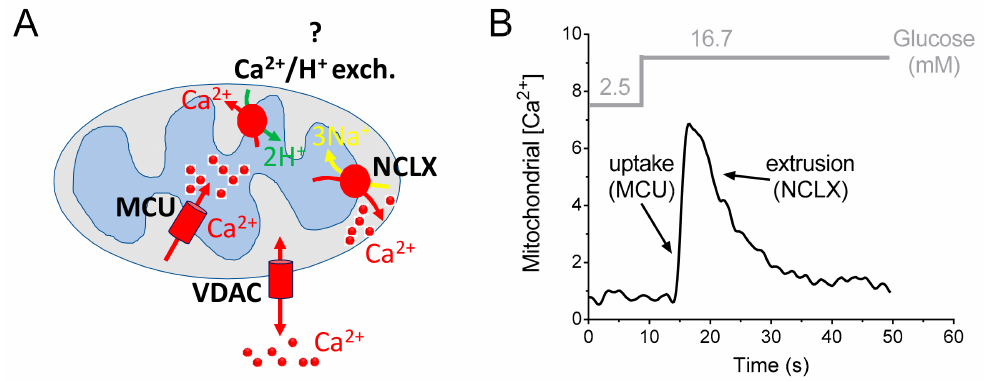
Figure 3. Contribution of mitochondrial Ca 2+ uptake and mitochondrial Ca 2+ extrusion to mito- chondrial Ca 2+ signaling in the pancreatic β -cell. ( A ) Ca 2+ transport proteins of pancreatic β -cell mitochondria. In the outer mitochondrial membrane, the voltage-dependent anion channel VDAC facilitates the diffusion of Ca 2+ , ions and other small solutes. However, mitochondrial Ca 2+ uptake is mainly regulated at the level of the inner membrane. Therefore, in β -cell mitochondria, the influx of Ca 2+ into the matrix is mediated by the Ca 2+ -selective channel MCU complex; Ca 2+ is then extruded by the Na + /Ca 2+ exchanger NCLX. The existence and the molecular identity of a pancreatic β -cell mitochondrial Ca 2+ /H + exchanger has not yet been proven and is here highlighted with a question mark (?) (see text for details). ( B ) Example of a calibrated trace of mitochondrial Ca 2+ elevation in the pancreatic β -cell line INS-1E stimulated with glucose, as indicated (gray). The uptake and release phases of the mitochondrial Ca 2+ are highlighted. The transporters which have been demonstrated to substantially contribute to the uptake and the release are MCU and NCLX, respectively. To calibrate mitochondrial Ca 2+ , INS-1E cells were transfected with the genetically encoded mitochondrial lumi- nescence Ca 2+ sensor aequorin, which is reported to overestimate the average Ca 2+ rise in cellular compartments